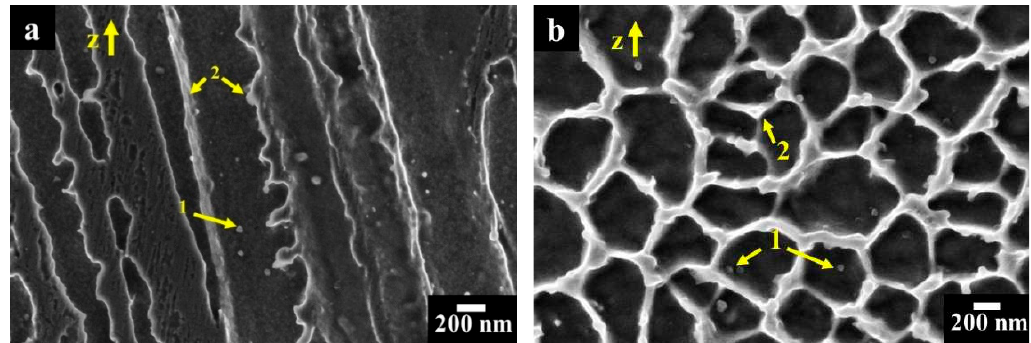
Figure 6. FESEM images of as-built IN625 sample at high magnification ( a ) columnar dendritic structures with nanoprecipitates (1) and segregation of Nb and Mo within the inter-dendritic zones (2); ( b ) cellular dendritic structures with nanoprecipitates (1) and segregation of Nb and Mo within the inter-dendritic areas (2).